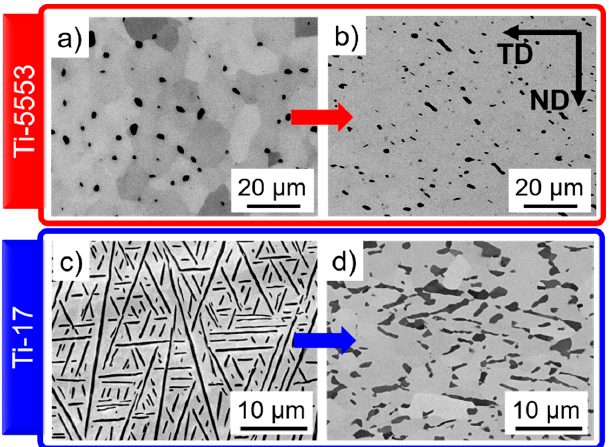
Figure 2. Microstructures of the ( a , b ) Ti-5553 and ( c , d ) Ti-17. Microstructures after heat treatment for 15 min at ( a ) 820 °C, ( c ) 810 °C. Microstructures after deformation at 0.001 s − 1 and ( b ) 820 °C, ( d ) 810 °C. The α - and β -phases are the darker and lighter phases, respectively.